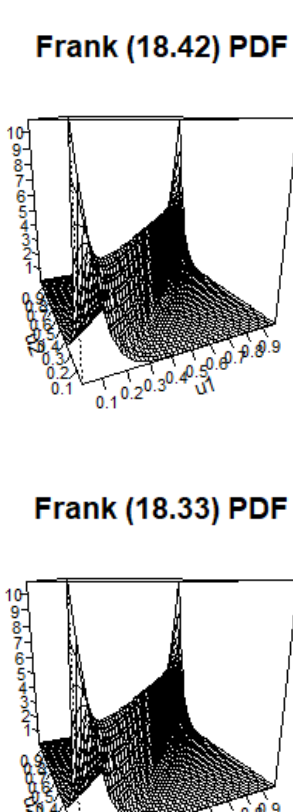
Figure 11. Gaussian(0.8) c.d.f. and p.d.f.